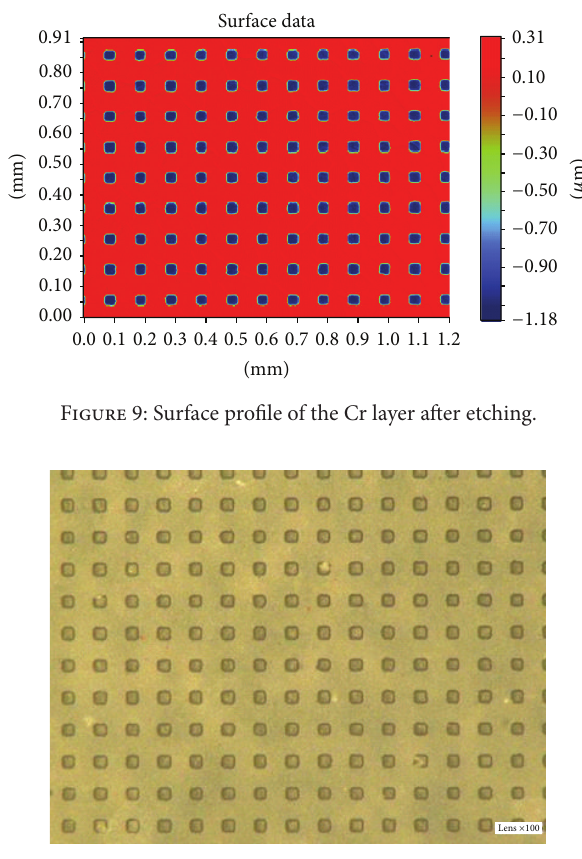
Figure 10: Optical micrograph of the quartz mold by ICP. surface smoothness. Then, the quartz microhole mold was produced by ICP etching by using the Cr film as a protective layer. Figure 10 shows the optical micrograph of the quartz mold. Figure 11 demonstrates the sweep test results of the mold, as detected by the stylus profiler. The size and the depth of the square hole were 54 𝜇 m × 54 𝜇 m and 231 𝜇 m, respectively. The holes were uniformly distributed and the roughness of the mold surface was good for